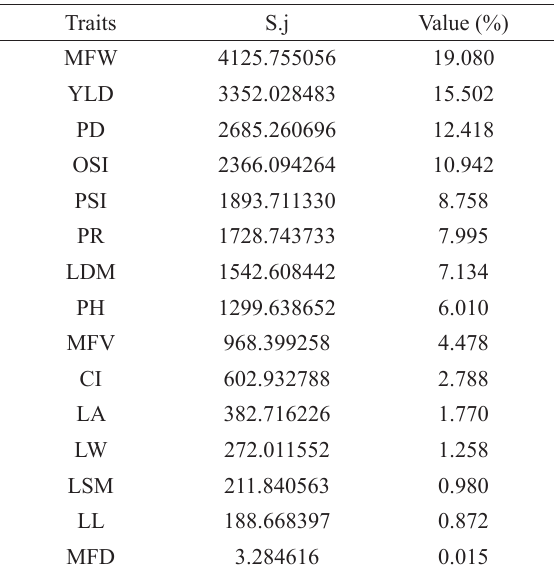
Relative contribution of 15 morpho-agronomic traits for genetic diversity in 30 promising registered Coffea canephora genotypes based on Singh (1981)’s method, using generalized Mahalanobis distance (D 2 ). Vila Valério